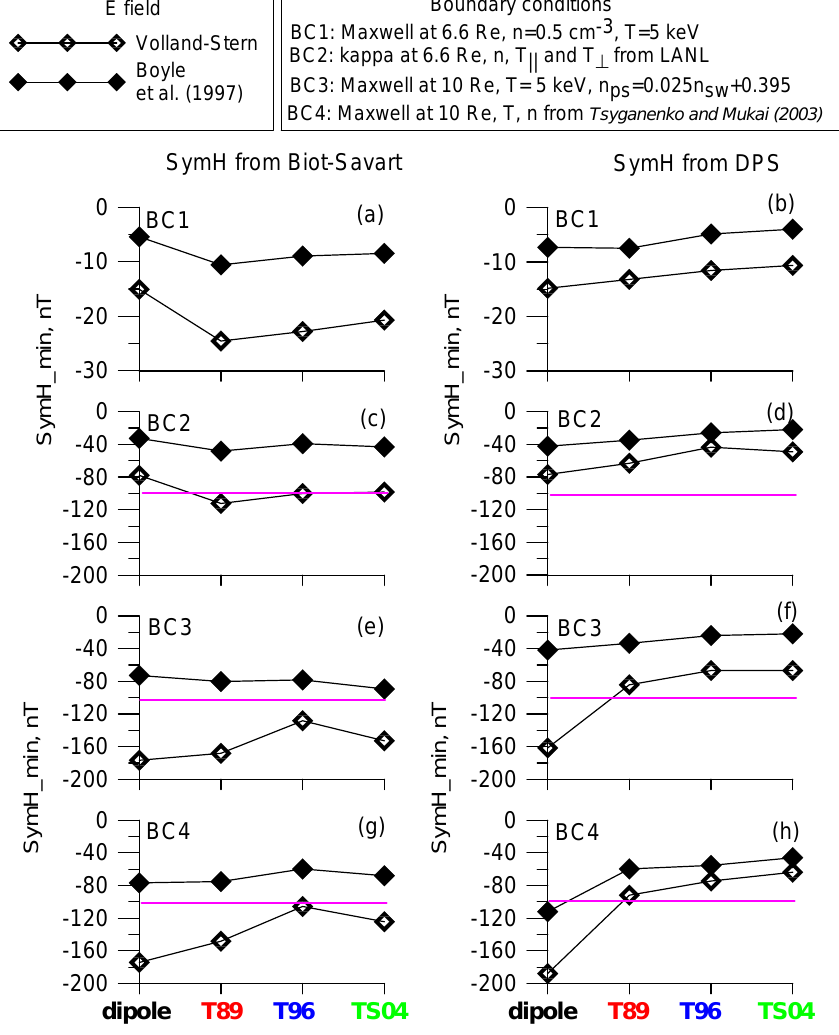
Fig. 12. Minimum SymH* values of the modeled SymH* profiles shown in Figs. 8 and 9 during 6–7 November 1997 storm. Purple horizontal lines mark the observed SymH* minimum